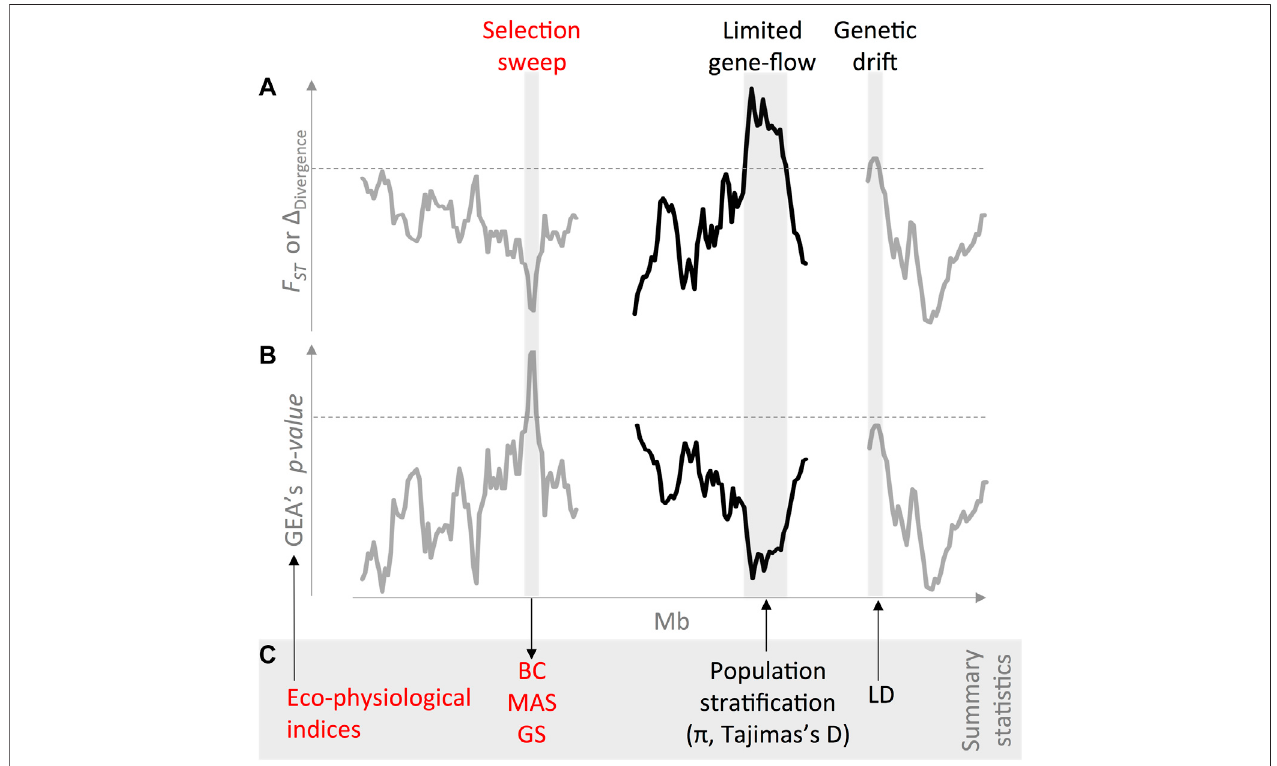
FIGURE 2 | An integrated case study inspired in common bean ( Phaseolus vulgaris L.) accessions exempli fi es how to identify and harness natural signatures of environmental adaptation across diverse genepools. First, (A) genome-wide patterns of genetic divergence, as measured by the F ST and delta divergence (Roesti et al., 2014) statistics, inform underlying confounding demographic processes across wild accessions (Blair et al., 2012) and landraces (Blair et al., 2009). Even though highly polymorphic markers have traditionally been preferred for demographic inferences (Blair et al., 2009; Kwak and Gepts, 2009), modern SNP genotyping technologies also enable reconstructing the genomic landscape of divergence at a higher resolution (Cortés et al., 2011; Wu et al., 2020). Once potential confounding demographic patterns have been accounted for, (B) it is then feasible to disentangle genuine (in red) signatures of environmental adaptation (Cortés et al., 2018b) from spuriousconcurringgeneticdriftduetogenomicconstrainingfeaturessuchaslowrecombiningregions,reducedeffectivepopulationsize,andtranslocations(Blairetal., 2018). In order to improve genome – environment associations (GEA), the fi eld has moved from the candidate gene approach (Cortés et al., 2012a; Cortés et al., 2012b; Blair et al., 2016; Buitrago-Bitar et al., 2021) into full genomic scans (Cortés and Blair, 2018a; López-Hernández and Cortés, 2022), which better account for linkage disequilibrium (LD) heterogeneity. It is also advisable to target discrete abiotic pressures by explicitly relying on the mechanistic ecophysiological models (Cortés et al., 2013) such as drought (Cortés and Blair, 2018a) and heat stress (López-Hernández and Cortés, 2022). Finally, (C) these combined summary statistics (i.e., ecophysiologicalindices,population strati fi cation, and LD)canultimately redound in prebreeding efforts aimingtointrogress exoticadaptivevariationintoelite lines, for instance, via backcrossing (BC) schemes for abiotic (Muñoz et al., 2003; Blair et al., 2006; Blair and Izquierdo, 2012; Burbano-Erazo et al., 2021) and biotic (Garzon et al., 2008) stresses, all guided with indirect (Miklas et al., 2006) genomic selection tools such as marker-assisted selection (MAS) and genomic selection, GS (Cortés et al., 2020a; Cortés et al., 2020b; Cortés and López-Hernández, 2021) within a moder enviromics approach (Cooper et al., 2021). Different line colors stand for hypothetical distinct chromosomes. Dashed horizontal lines mark signi fi cance